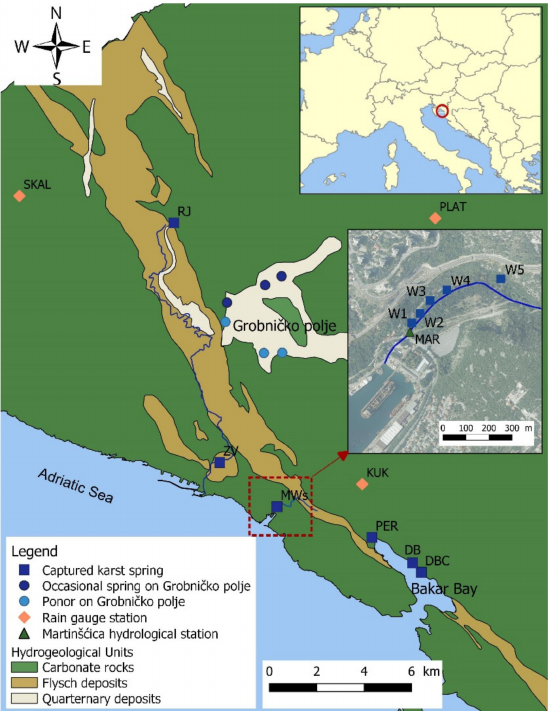
Figure 1. Upper right corner: position of the study area. The main map: hydrogeological map of the analyzed area showing the main karst springs (RJ—Rjeˇcina Spring, ZV–Zvir, MWs—Martiš´cica